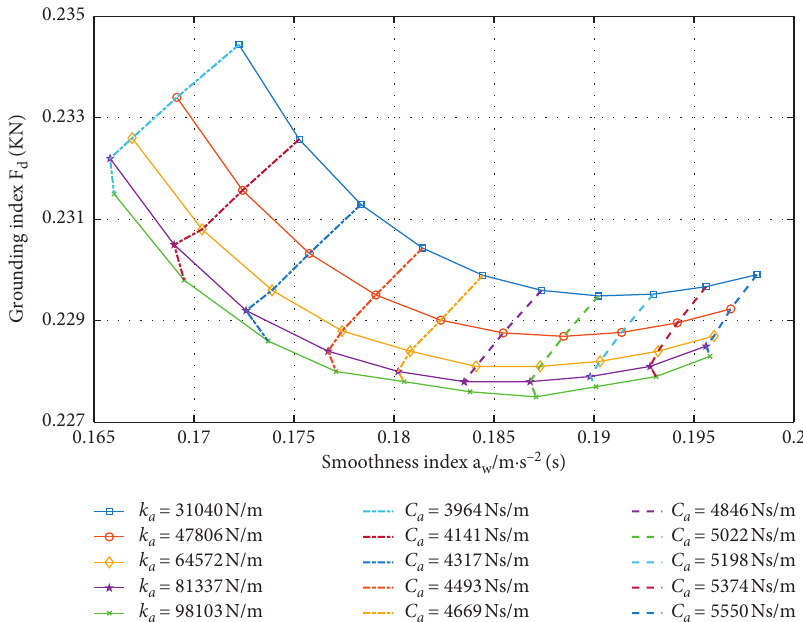
Figure 6: Effect of matching different stiffnesses and dampings on the vertical performance index.